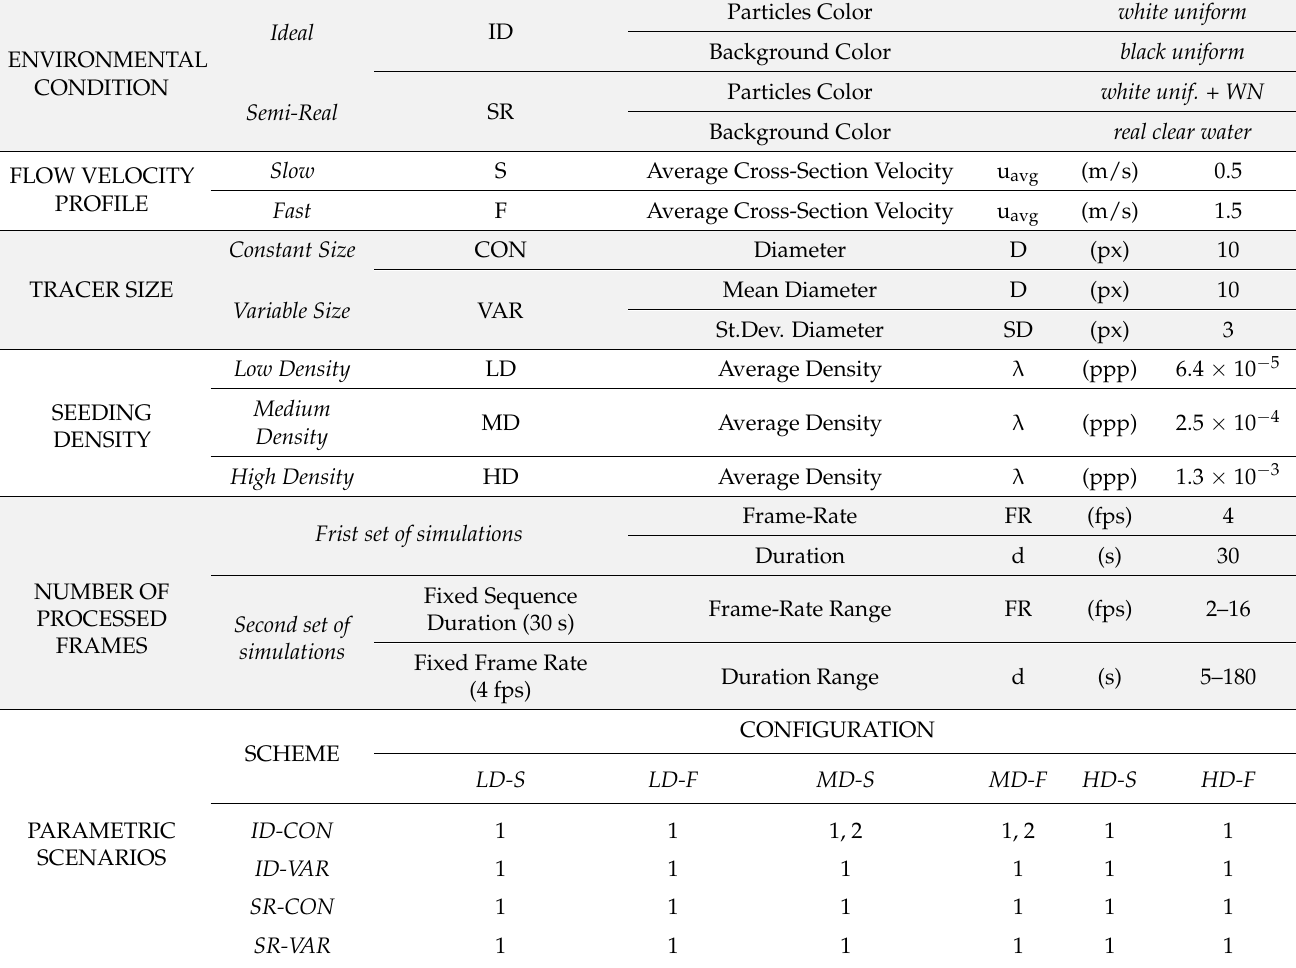
Table 1. Parameters and configurations considered for generating the 52 different scenarios. The schematic representation in the bottom refers to the different scenarios considered in the first (1) and the second (2) set of simulations. The scenarios are obtained combining schemes (combination of environmental and tracer size conditions) and configurations (combination of seeding density and surface velocity profile). WN = white noise; px = pixel; ppp = particles per pixel; fps = frame per